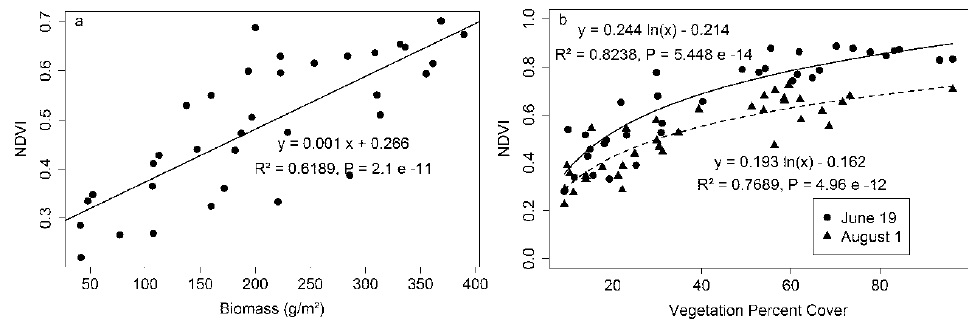
Figure 4. NDVI versus biomass ( a ) and vegetation percent cover ( b ). Biomass was measured on 4 August and percent cover was measured on 19 June and 1 August 2014. Table 1. Dependence of NDVI on species richness and vegetation percent cover. Values shown are multiple linear regression parameters, including intercept, coefficients for log(species richness) and log(percent cover), R 2 and F values. Regressions have degree of freedom = 32. Significant codes: NS, 0.05 < p , *, 0.05 < p < 0.01, **, 0.001 < p < 0.01 and ***, p < 0.001. 0619 and 0801 represent the sampling dates (19 June and 1 August